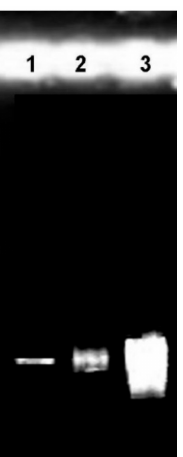
Figure 3. DNA agarose electrophoresis of E. coil (1) control; ( 2 ) UV radiation individual generated